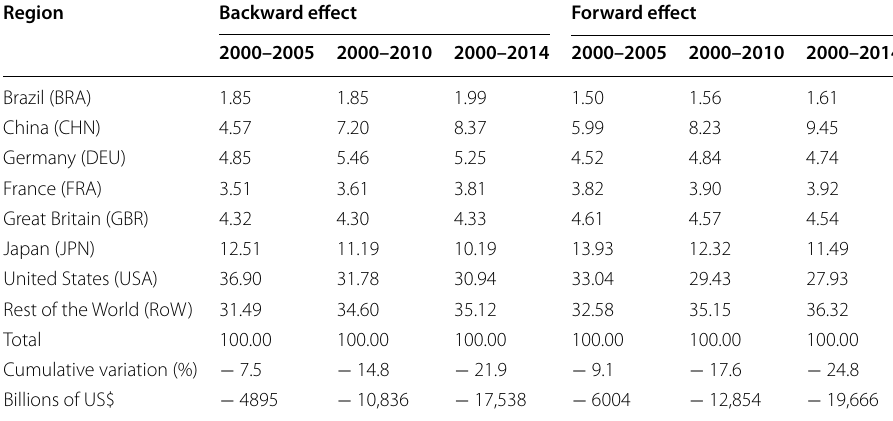
Source: research